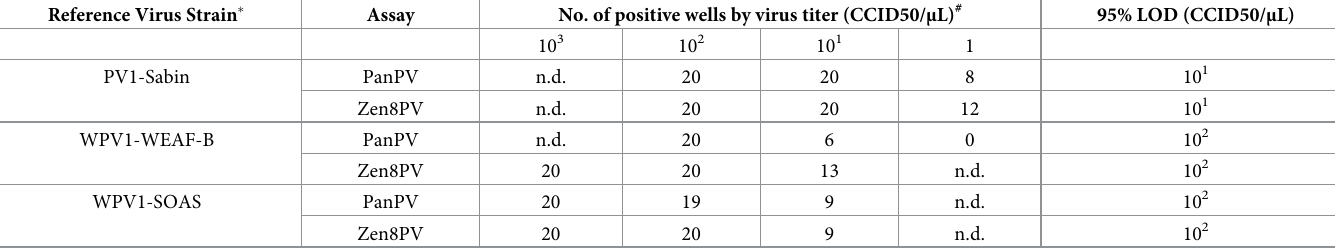
Table 3. Limit of detection for poliovirus serotype 1 with PanPV and updated PanPV assays tested with 20 replicates. Reference Virus Strain �